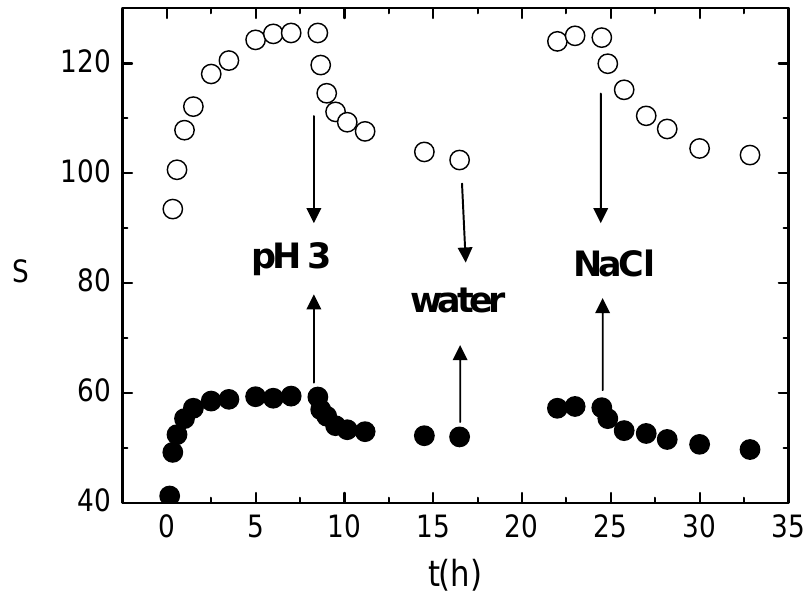
Figure 5. Swelling/de-swelling behaviour: water weight fraction, S, in XGE hydrogels stored sequencially in HCl 10 -3 M, water, 0.1M NaCl. Empty symbols: XGE1; full symbols XGE2.